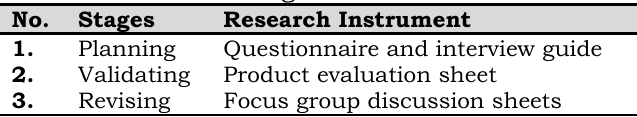
Table 1. The stage and the